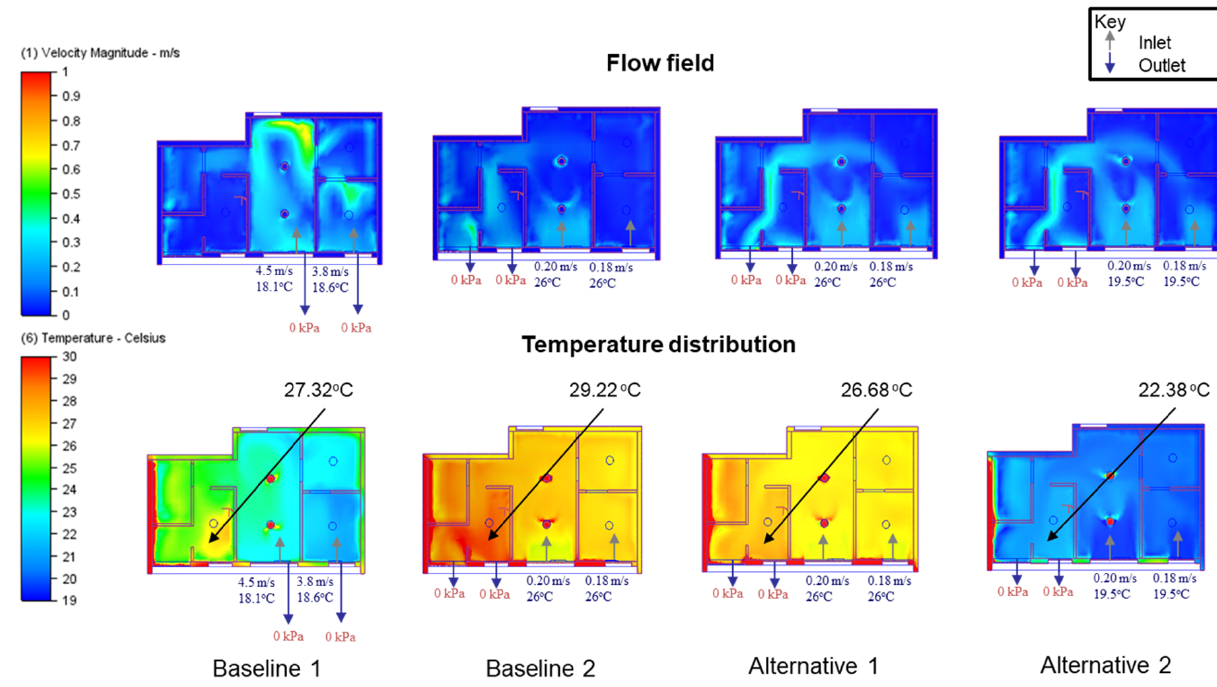
Figure 13. Comparison of CFD results between four design options (at nose level, around 1.6 m, 60% of storey height).